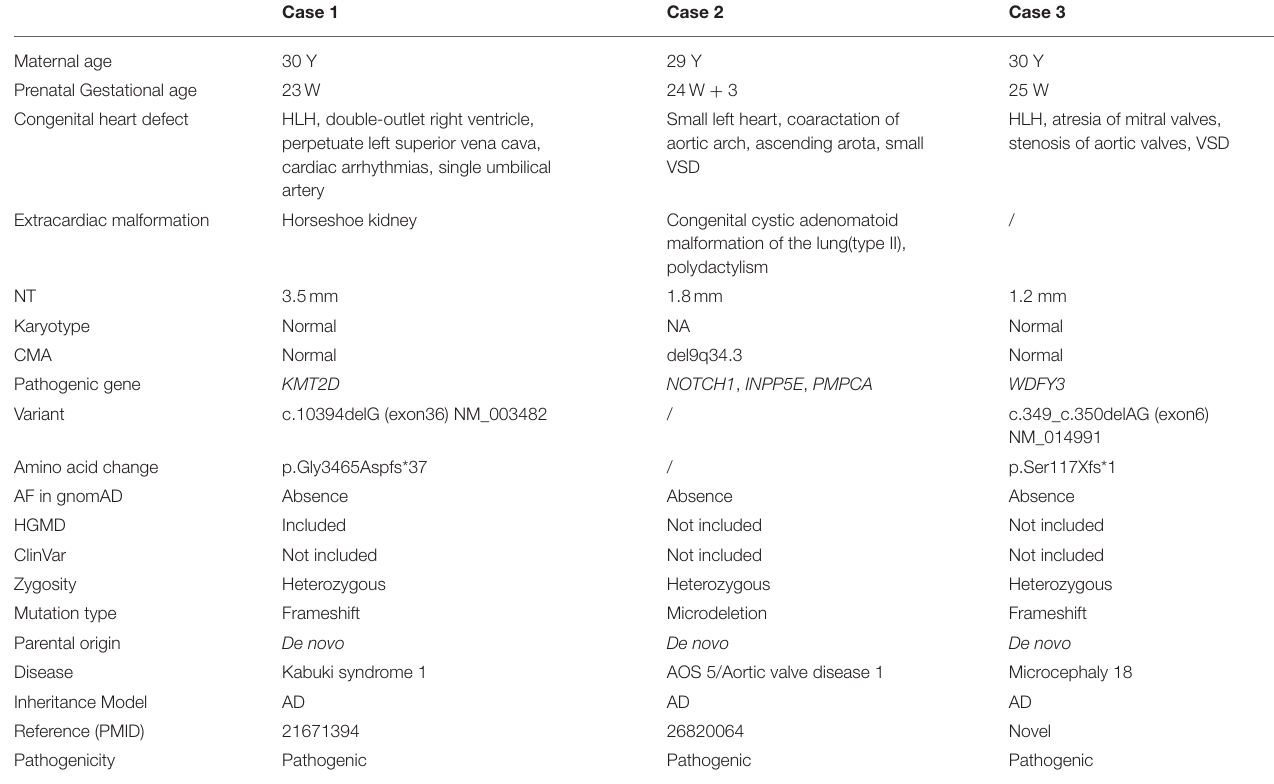
TABLE 1 | Prenatal phenotype and genotype information for the cohort. Case